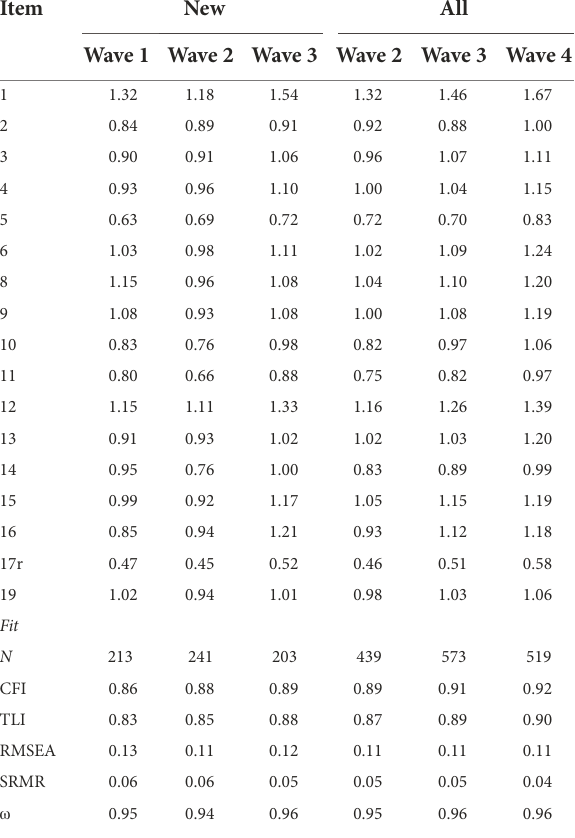
TABLE 3 Factor loadings and fit indices by Wave for groups of new and all participants. Item New All